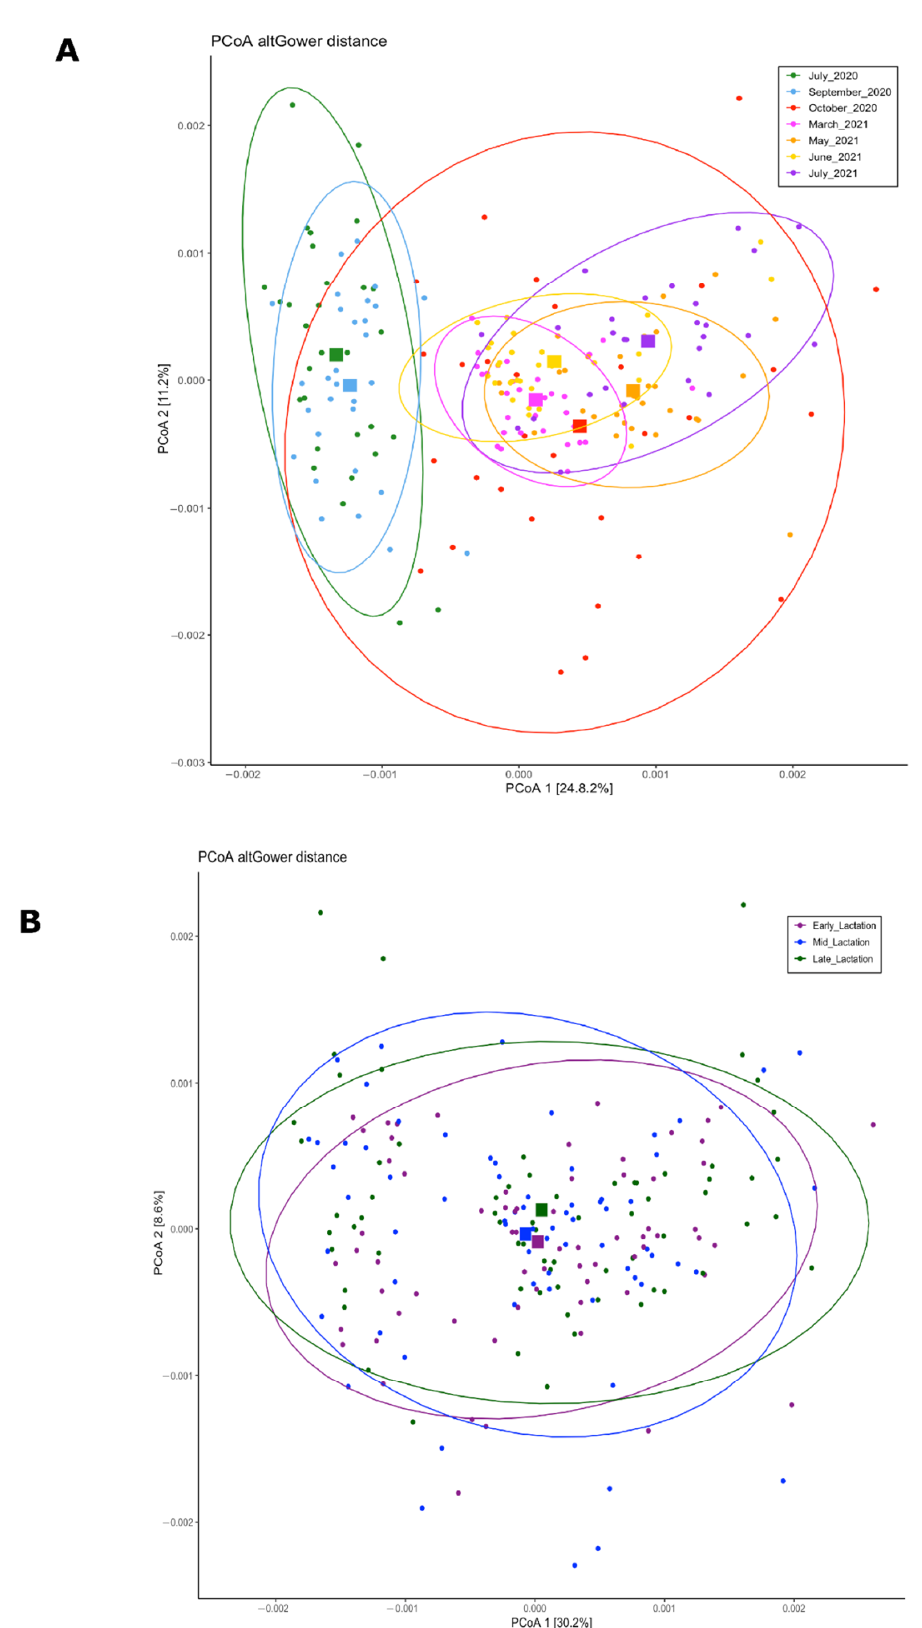
Figure 2. Principal coordinates analysis (PCoA) based on Gower distances. ( A ) PCoA grouped by sampling time. ( B ) PCoA grouped by lactation stage groups. Proportion of variance explained